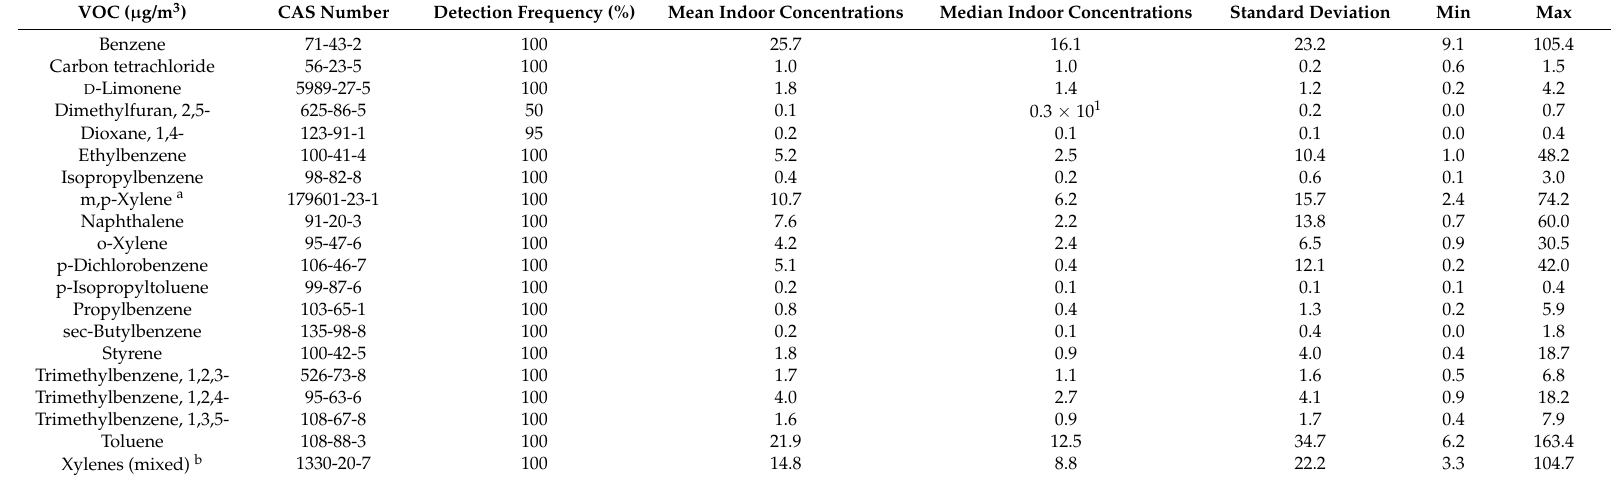
Table 1. Indoor VOC concentrations across all sampling locations.